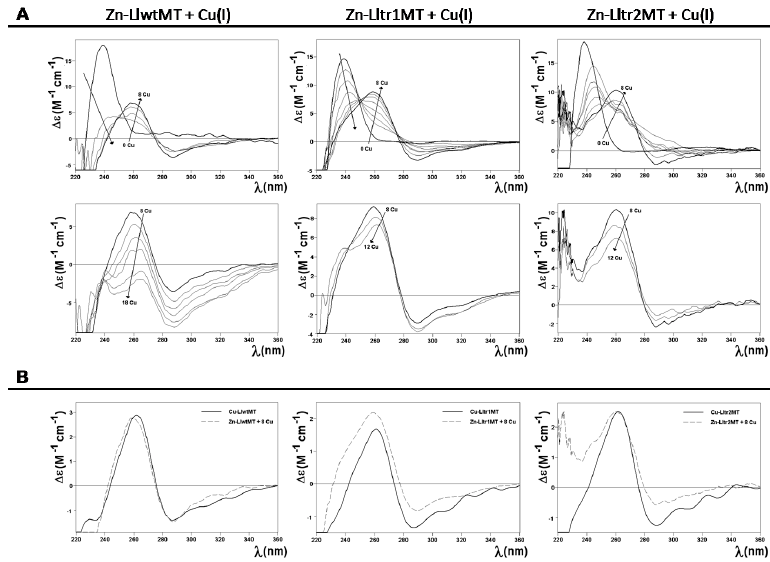
Figure 7. Zn(II)->Cu(I) replacement reaction on the Zn 9 -LlwtMT, Zn 6 -Lltr1MT, and Zn 6 -Lltr2MT complexes. ( A ) CD spectra of a 10 µ M solution of the Zn-LlMT samples, titrated with a Cu(I) solution at neutral pH; ( B ) Comparison of the CD spectra (normalized) of the three recombinant productions of Cu-LlMT with those obtained from the in vitro metal displacement reactions.